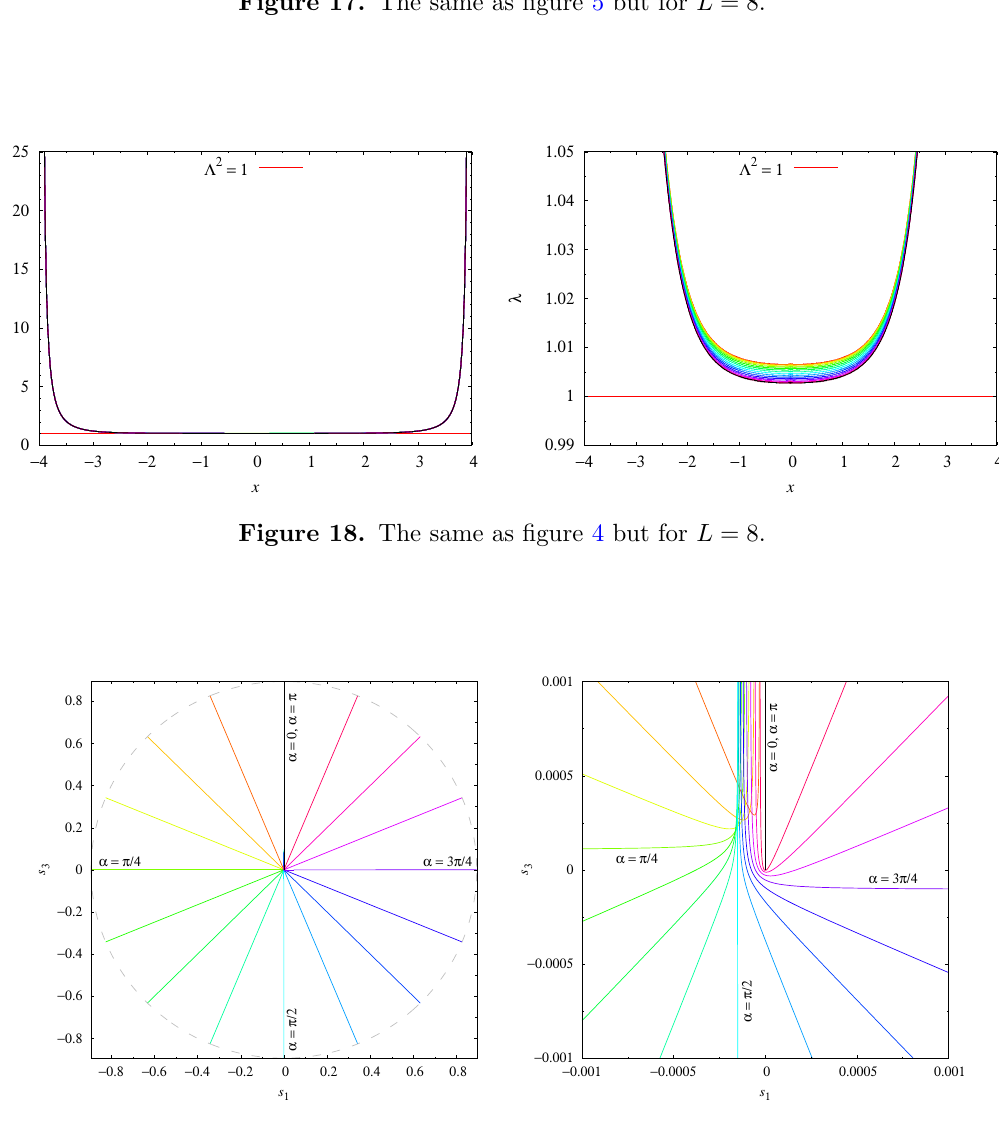
Figure 19. The same as (cid:12)gure 6 but for L = 8.